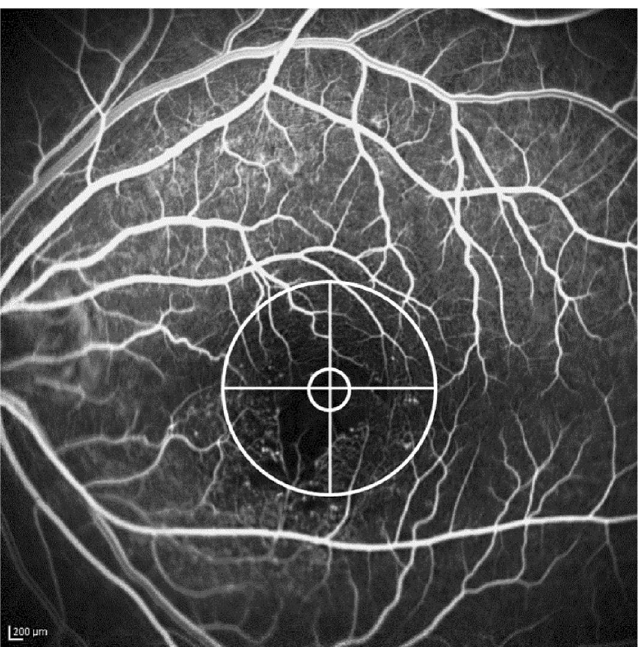
Figure 2. Quantitative assessment of capillary ring loss and the foveal avascular zone outline, which were measured using the 3 mm zone of the Early Treatment Diabetic Retinopathy Study grid circle. The image demonstrates the degree of macular ischemia in one